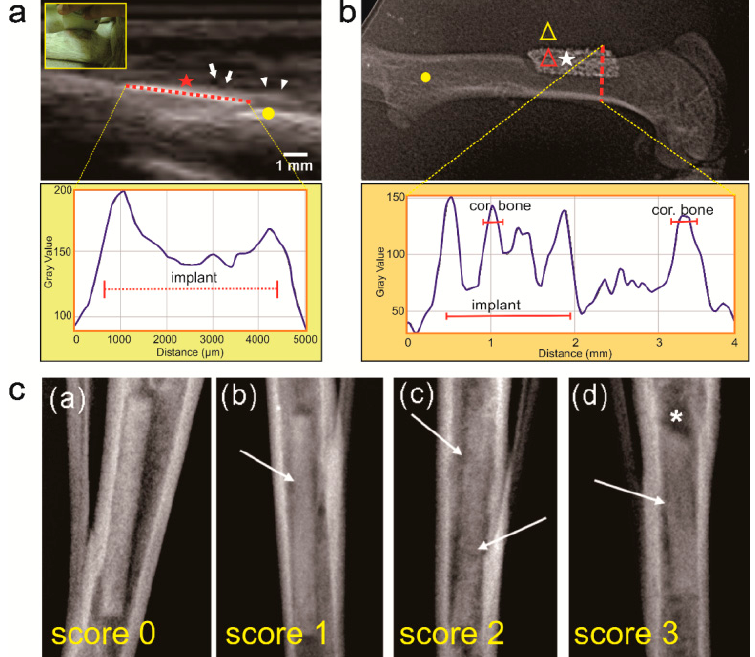
Figure 4. Qualitative and quantitative assessment of tissue-implant interaction: ( a ) ultrasonography (USG) image analysis of Fe-bioceramic plate in sheep as a way to quantitatively assess corrosion based on the reflected sound wave using ImageJ image processing software; ( b ) radiography-image analysis of porous Fe implant in a Sprague-Dawley rat using the same ImageJ software but based on the opacity of the X-ray image; ( c ) radiographic score system used for LANd442 Mg implant in New Zealand white rabbits over 4–10 weeks as another approach in qualitative assessment of bone tissue reaction and structure change of implant. Note: arrow tip = new bone tissue around the implant, short arrow = fluid around the implant, red star and white star-1 = implant, circle = bone, red triangle = implant, yellow triangle = muscle, long arrows: = structural loss, white star-2 = shape changes. Adapted with permission from Elsevier [51,61].